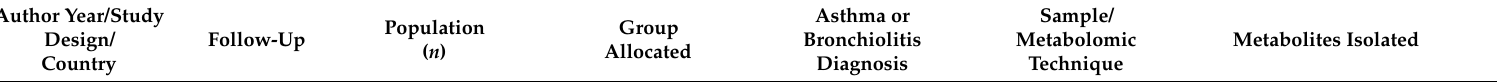
Table 1. Characteristics of pediatric asthma metabolomic studies reviewed from birth to school